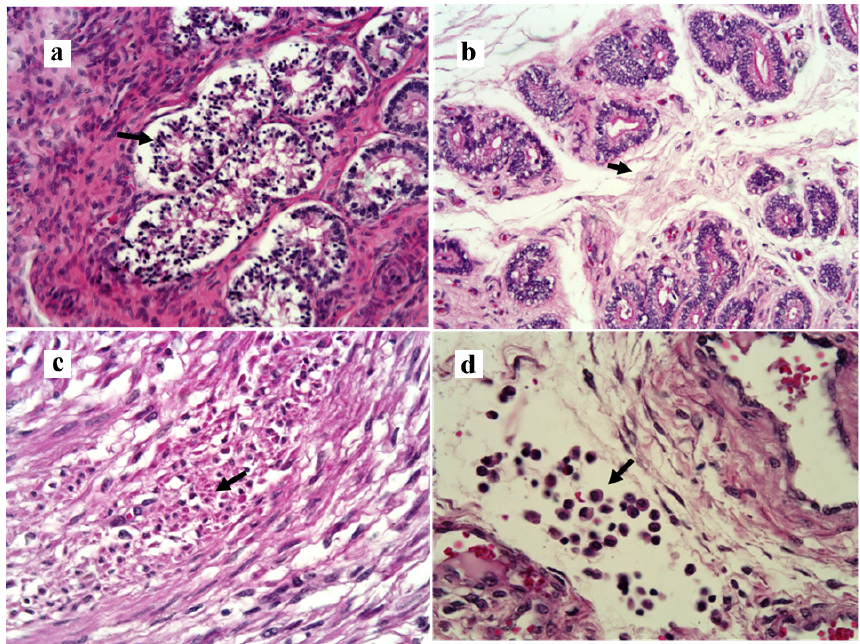
Figure 2 - Photomicrography. Panel a - Uterus, destruction of glandular epithelium and infiltration of lymphocytes (narrow, H&E, 200X); Panel b - Edema of uterine submucosa (narrow, H&E, 200X); Panel c- Cervix, muscular necrosis and eosinophils (narrow, H&E, 400X); Panel d - Uterine submucosa, focal PMN infiltration (narrow, H&E,